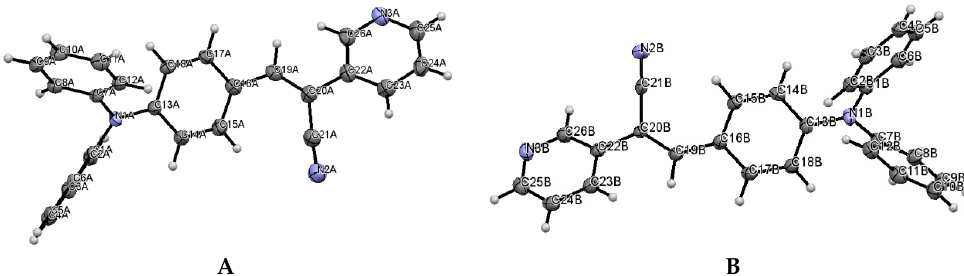
Figure 2. Displacement ellipsoid plots (50% probability level) of I . The two crystallographically independent molecules A and B are shown separately.